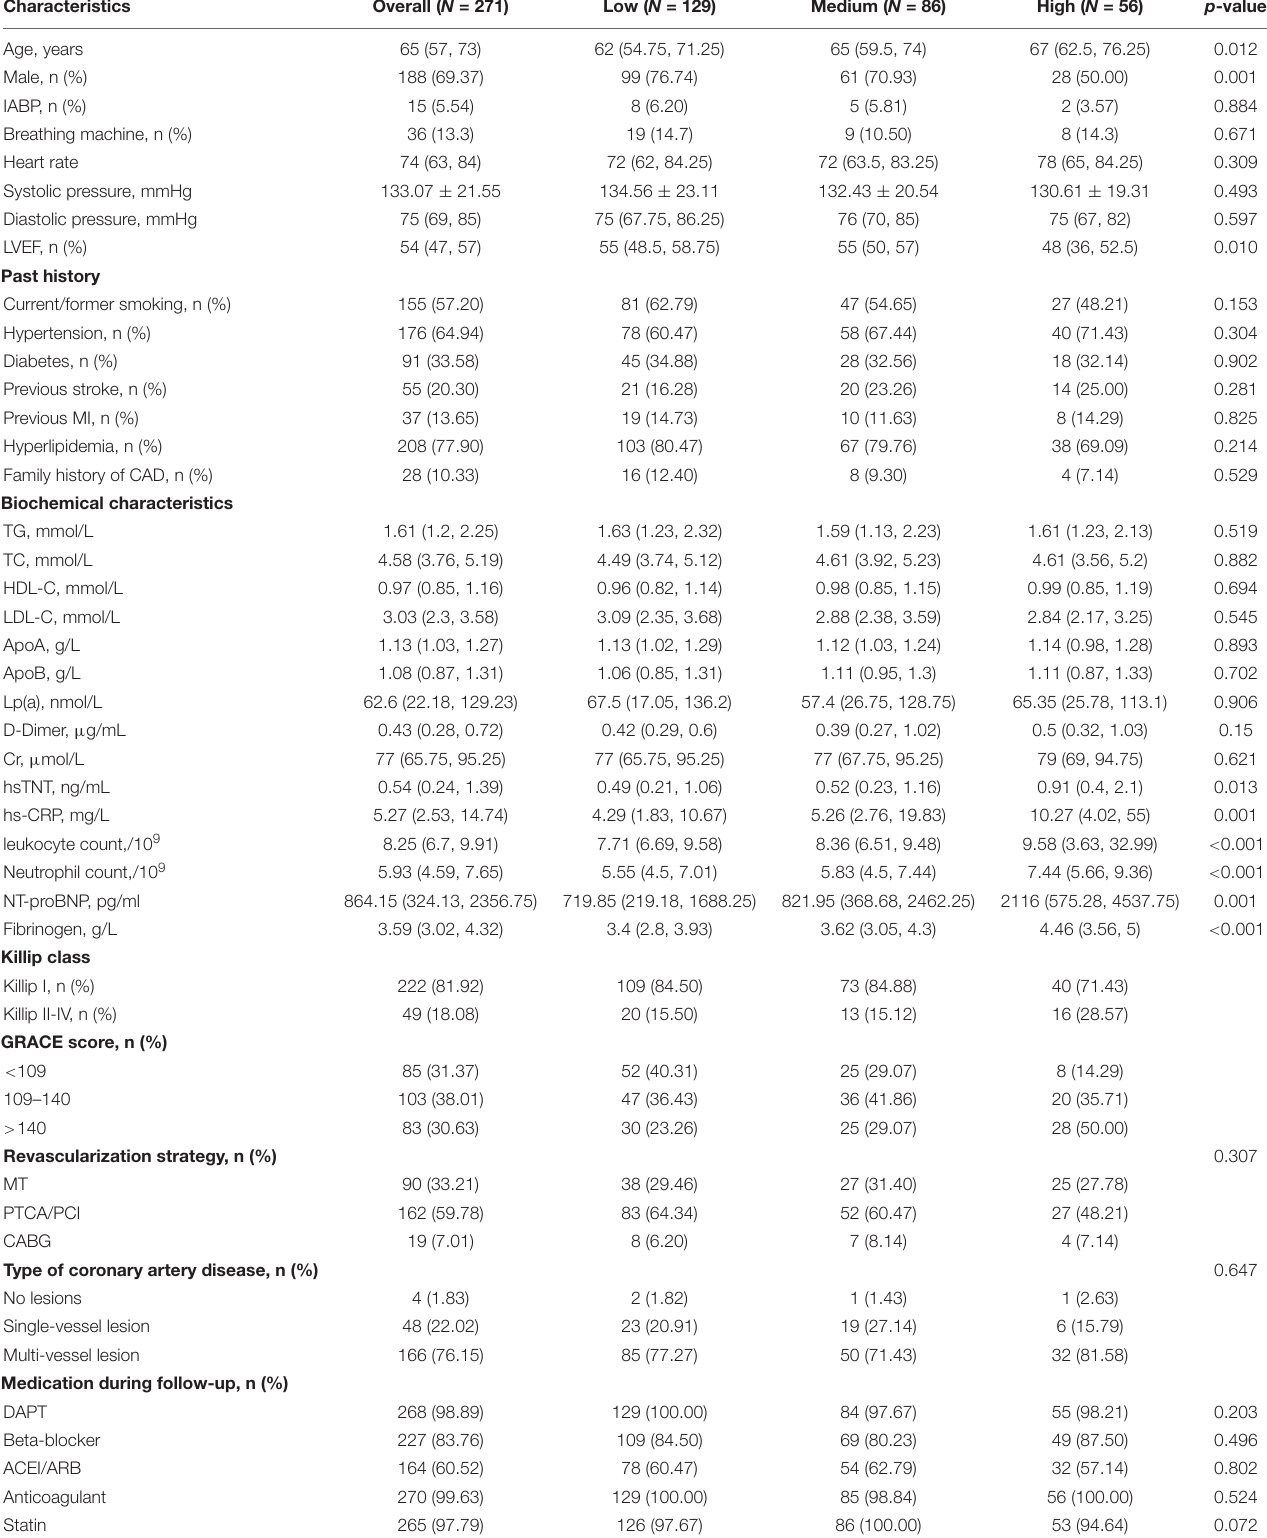
TABLE 2 | Baseline characteristics of the NSTEMI patients in different MPO level.